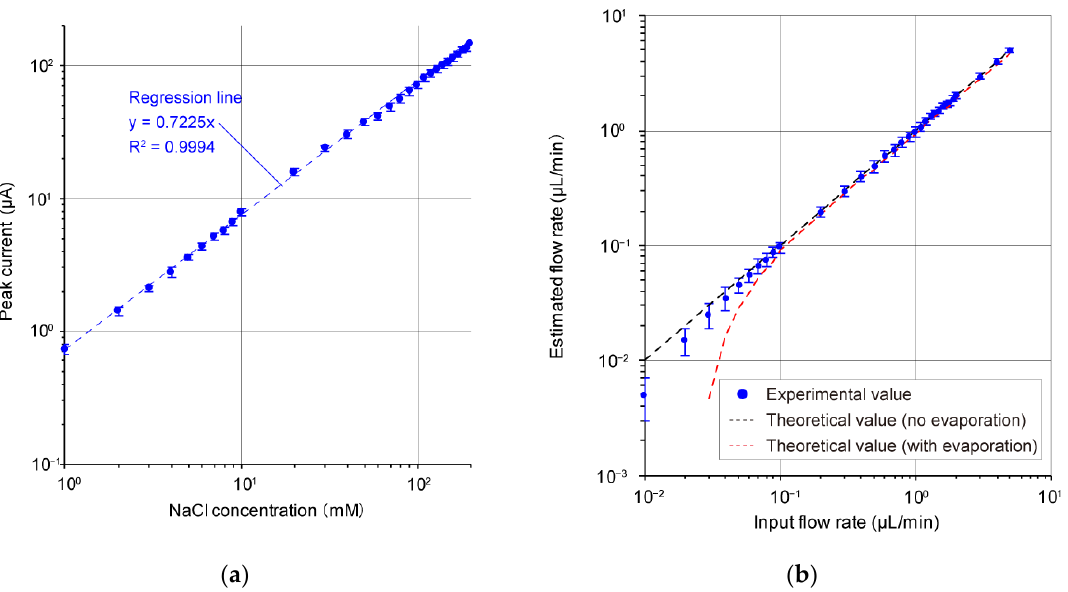
Figure 3. ( a ) Relationship between sodium chloride (NaCl) concentration in artificial sweat introduced into the microchannel and the obtained electrochemical peak current. ( b ) Relationship between artificial sweat flow rate in the microchannel and the estimated flow rate calculated from the recorded current signal. The data are shown as mean ± the 95% confidence interval.